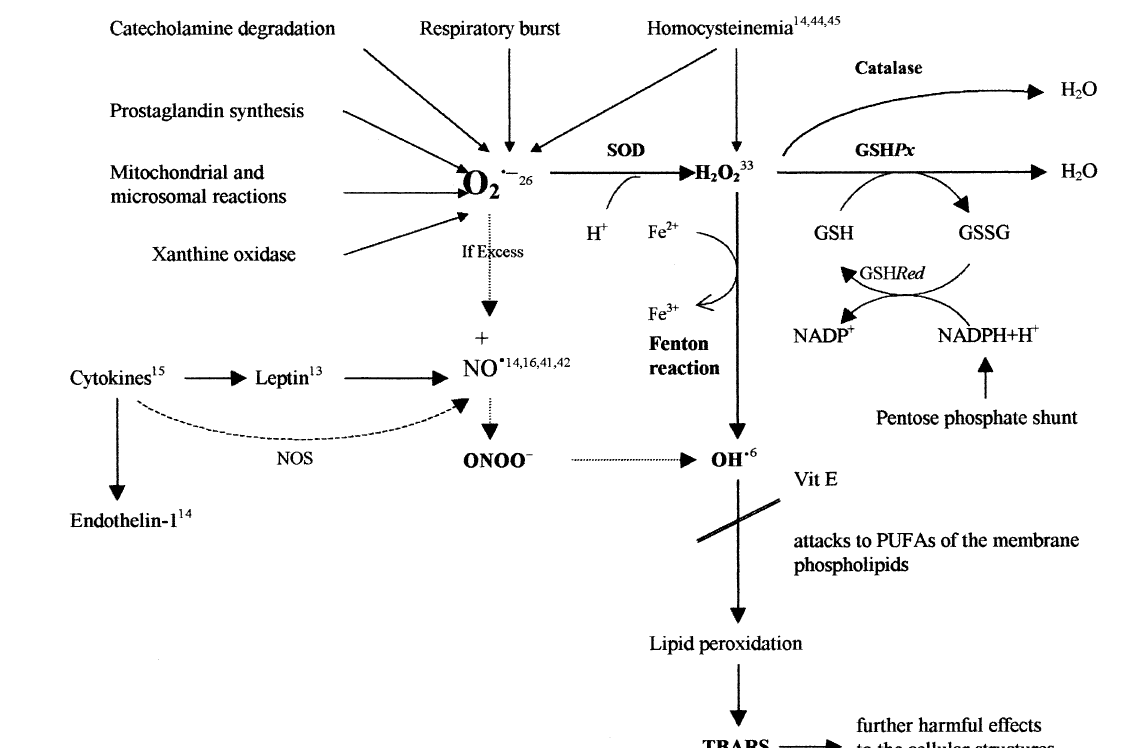
FIG. 1. Schematic representation of enzymatic ROS production, antioxidant system and lipid peroxidation in oxidative stress. Molecular oxygen can be reduced by various enzymatic reactions, and the formed superoxide anion ( O + (cid:1) hydrogen peroxide (H 2 O 2 ) by superoxide dismutase (SOD). H 2 O 2 is independently destroyed by catalase and glutathione peroxidase (GSHPx) in the presence of reduced glutathione (GSH). When they are produced in excess, a Fenton reaction develops and H 2 O 2 is reduced into hydroxyl radical (OH + ), the most potent ROS. Nitric oxide synthase (NOS), which produces the most abundant free radical NO + , can also contribute to oxidative stress. The short-lived NO + reacts with O + (cid:1) peroxynitrite anion (ONOO (cid:1) ) production, which is a potent and powerful long-lived free oxygen radical. ONOO (cid:1) further decomposes into OH + . The figure also shows our previous findings that could be incorporated into this figure by means of hypothetical aetiopathogenic mechanisms of BD. GSSG, oxidised glutathione; GSHRed, glutathione reductase; PUFAs, polyunsaturated fatty